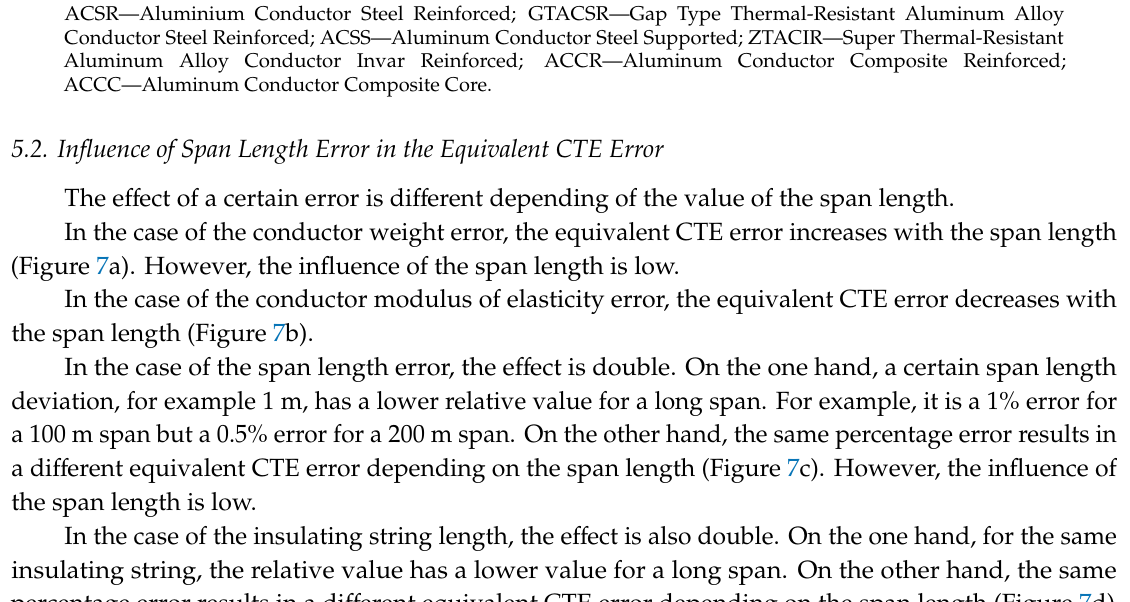
Table 5. Equivalent CTE errors for different HTLS conductors.